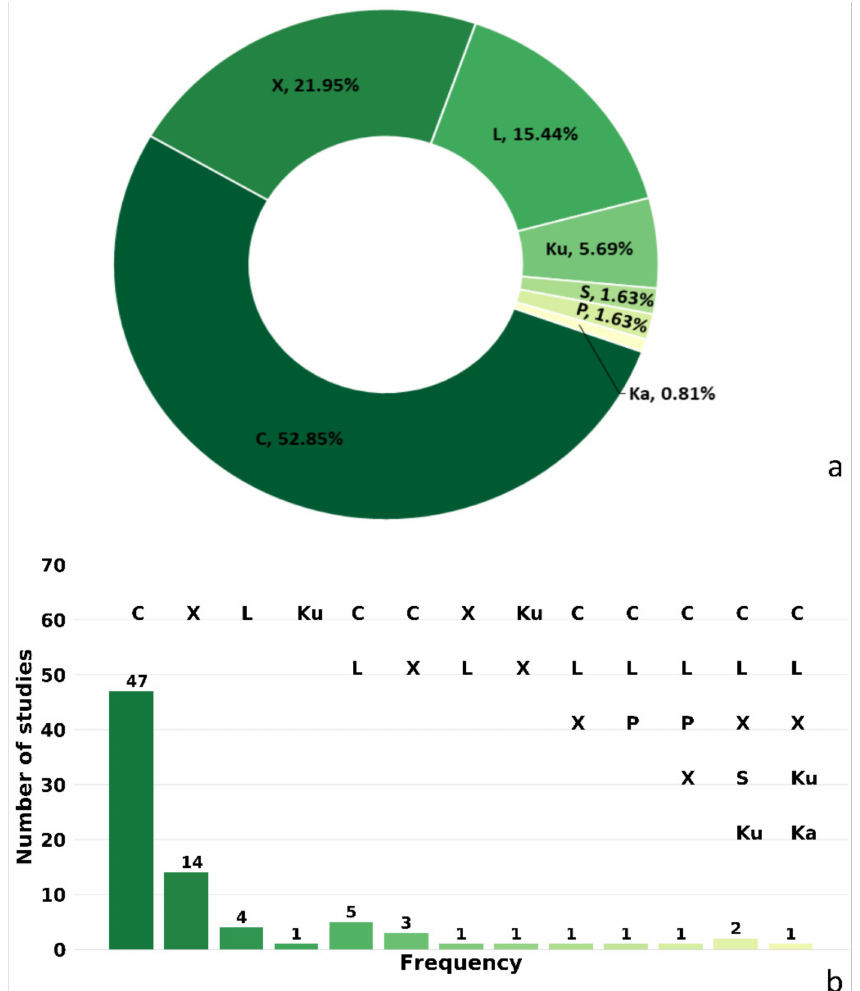
Figure 11. ( a ) SAR frequencies used, and ( b ) the combination of SAR frequencies studied in screened